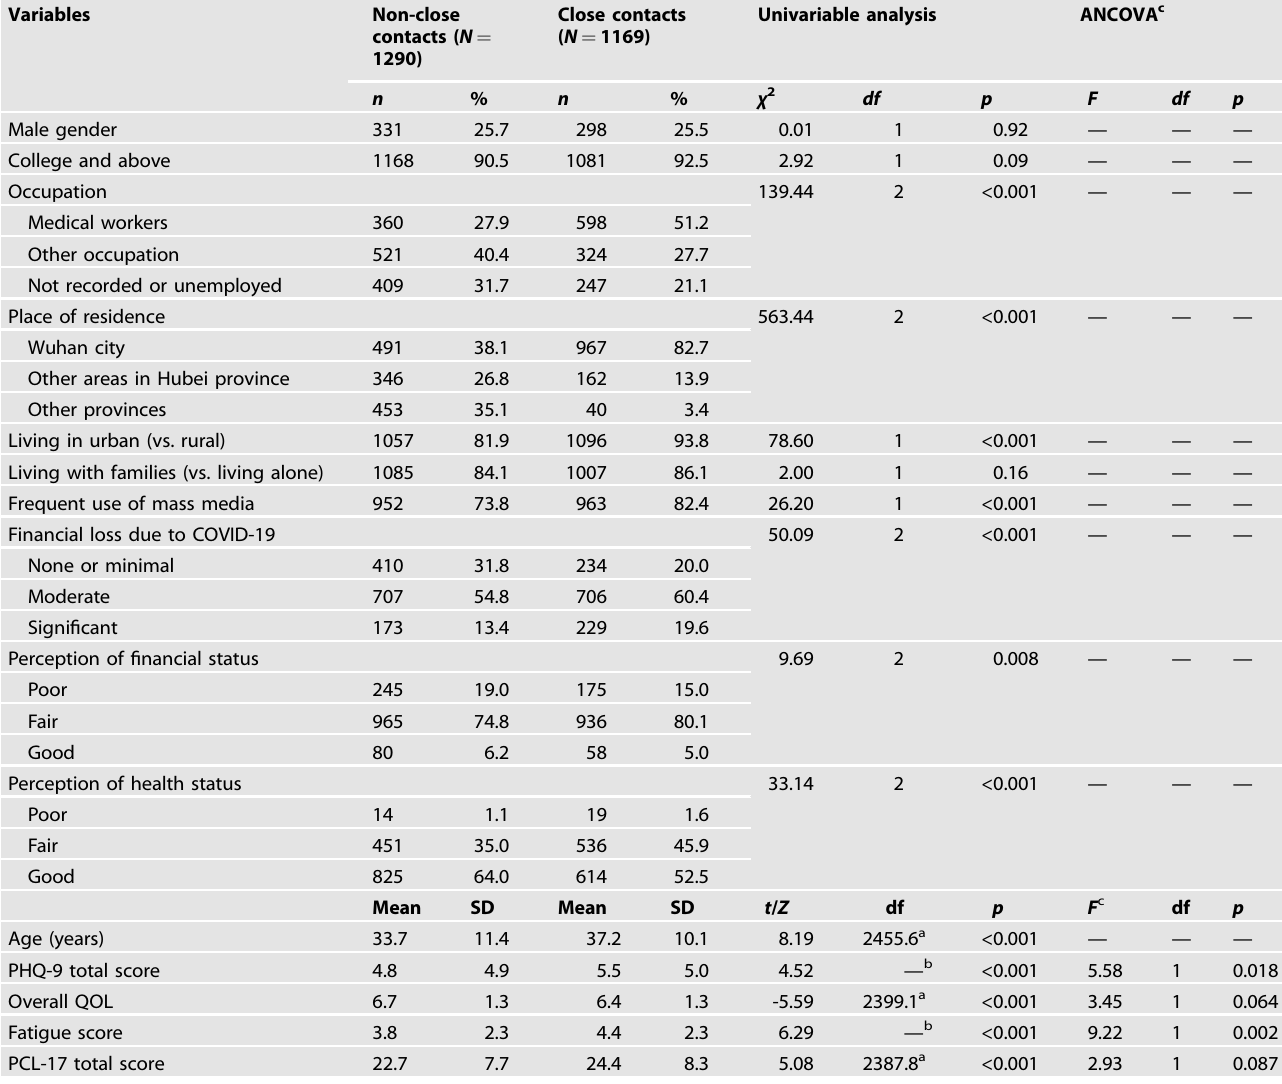
Table 1. Demographic and clinical characteristics of the whole study